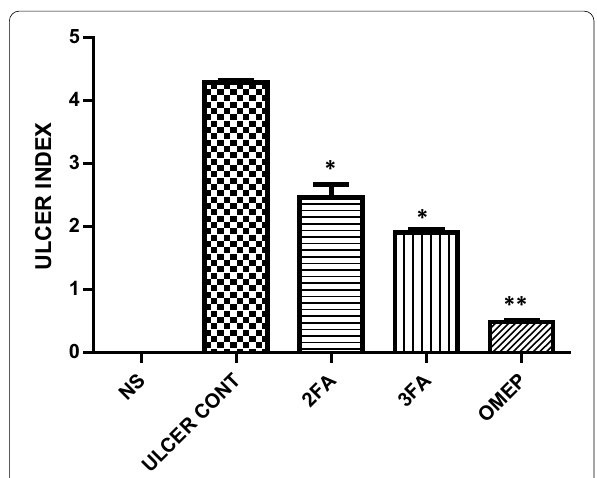
Fig. 1 Effect of graded doses of folic acid supplementation on pyloric ligation-induced ulcer in the rat. (* p < 0.05, ** p < 0.001 cf ulcer control) NS Normal stomach, ULCER CONT = Ulcer control, 2FA